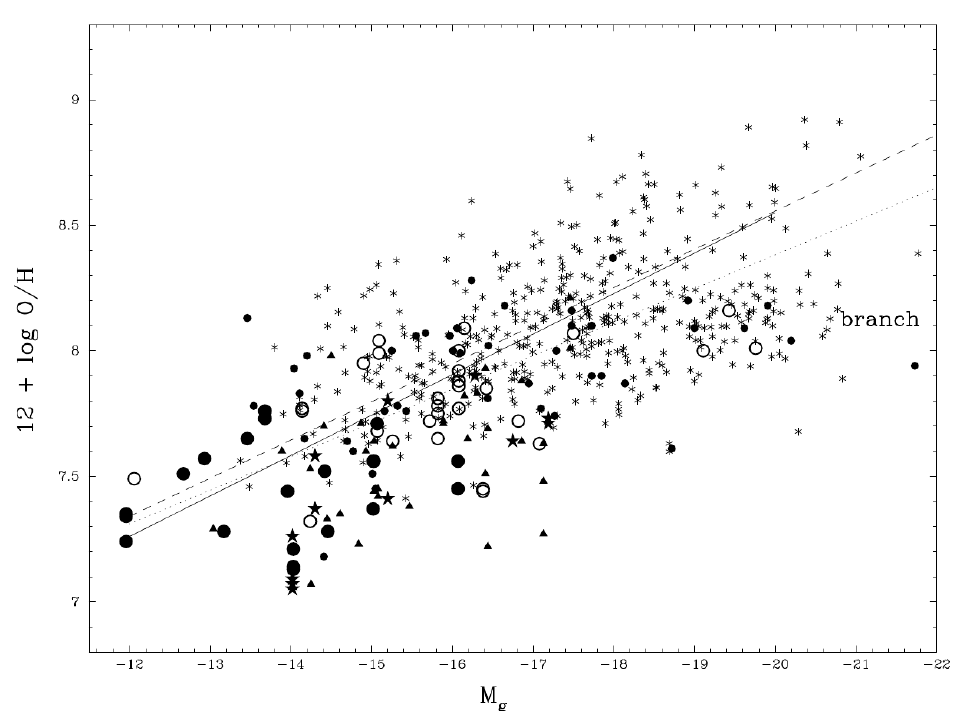
Figure 1. Oxygen abundances of mostly local galaxies as a function of absolute g-magnitude. ‘Branch’ on the right hand side indicates particularly distant objects ( z > 0.2). Small filled circles: data from [33,34]; large filled circles: data from [35]; asterisks: a Sloan Digital Sky Survey (SDSS) sample; open circles: 3.6m ESO data; stars: VLT data; triangles: additional VLT data from [36]. For more details, see